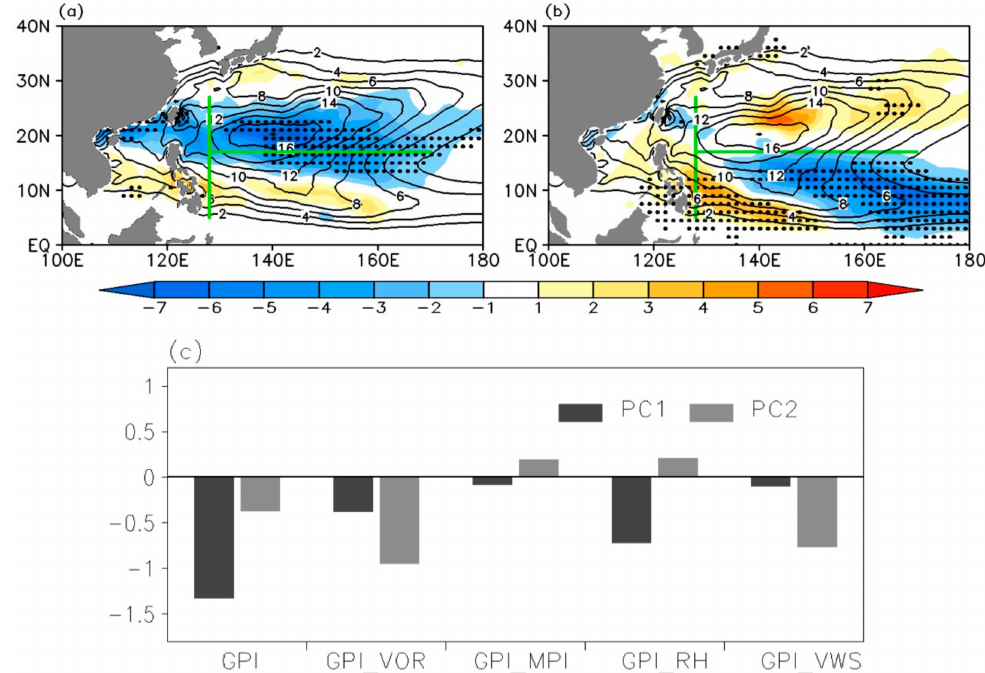
Figure 3. The difference in the GPI between the positive and negative phases of ( a ) PC1 and ( b ) PC2 (shading). The black contour is the long-term mean (1979–2020) of GPI in JJA. The dots mark regions where the differences are significant at the 95% confidence level. ( c ) Changes in the total GPI and each constituent term (i.e., low-level vorticity ( VOR ), maximum potential intensity ( MPI ), relative humidity ( RH ), and vertical wind shear ( VWS )) between the positive and negative phases of PC1 and